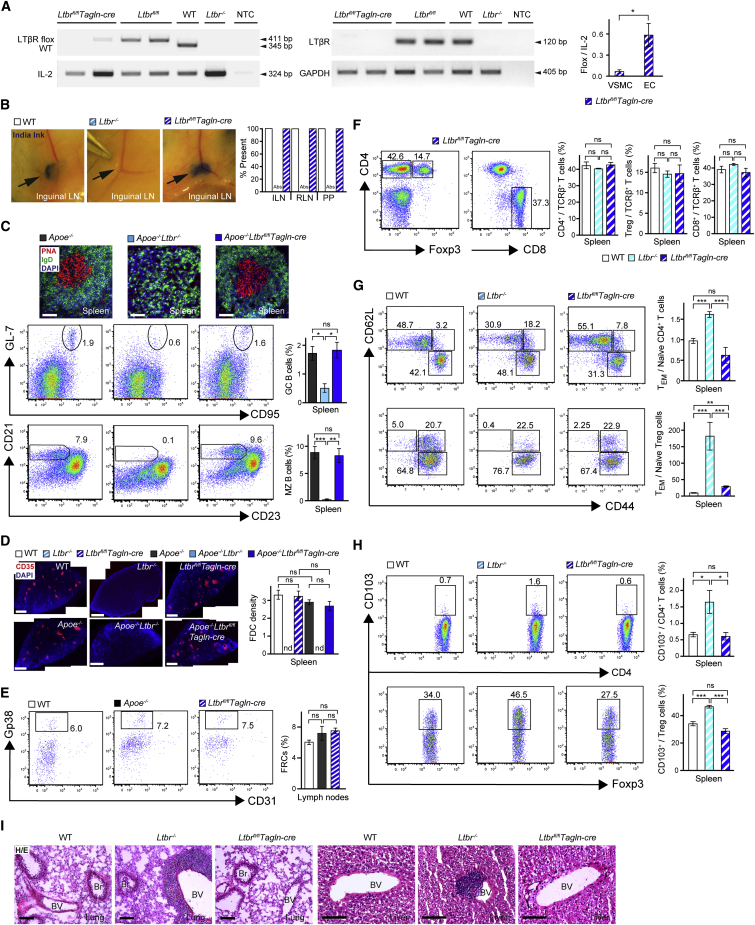
The Immune System of VSMC-LTβR Deficient Mice(A) Ltbr deletion in VSMCs. Validation of genomic Ltbr deletion in freshly isolated aortic VSMCs by PCR (left) and of Ltbr mRNA (middle); qRT-PCR show reduction of floxed Ltbr sequences in cultured aortic VSMCs compared to aortic endothelial cells (ECs) (n = 3 experiments) of Ltbrfl/flTagln-cre mice (right); NTC, no template control.(B) SLO neogenesis. Inguinal LNs (ILNs) were visualized by India ink injection into footpads of 8- to 10-week-old mice (n = 8) (left panels, arrow); all other LNs (data not shown) show similar results. SLOs in WT, Ltbr−/−, and Ltbrfl/flTagln-cre mice (n = 8) (right); RLN, renal LN; PP, Peyer’s patches; Abs, absent.(C) GC and MZ B cells in spleen. PNA+ GC B cells and IgD+ follicular MZ B cells in spleen (upper panel) (n = 8–12 sections in 5–7 mice per genotype). Flow cytometry show GC (middle panel) and MZ B cells (lower panel) in B220+ B cells from 78- to 80-week-old mice.(D) FDCs in spleen. Representative lower magnification montages of CD35+ FDCs and quantification of FDCs in spleen (n = 8–12 sections in 5–7 mice per genotype).(E) FRCs in LNs. Flow cytometry of Gp38+CD31− FRCs of CD45−Ter119− cells in LNs of 78- to 90-week-old mice (left panel).(F) T cell subsets in spleen. Flow cytometry of CD4+Foxp3− T cells, CD4+Foxp3+ Treg cells, and CD8+ T cells of TCRβ+ cells of 78- to 90-week-old Ltbrfl/flTagln-cre mice.(G) TEM and naive T cells in spleen. Flow cytometry of CD62L+CD44− naive, CD62L−CD44+ TEM, and CD62L+CD44+ TCM cells of CD4+ T cells of 78- to 90-week-old mice; TEM per naive T cell ratios of CD4+ T cells (upper panel) or CD4+ Treg cells (lower panel).(H) CD103+ cells in spleen. Flow cytometry plots show CD103+ cells from CD4+ (upper panel) or Treg (lower panel) cell gate of 78- to 90-week-old mice; bar graphs show the percentage comparison of CD103+ cells among CD4+ T or Treg cells at right.(I) Perivascular infiltrates in peripheral tissues. Hematoxylin and eosin (H/E) staining show leukocyte infiltrates around blood vessels (BVs) in lungs and liver. n = 3 mice per genotype. Br, bronchiole. Scale bar represents 50 μm (C and I); 500 μm (D). Flow cytometry data are representative of three experiments with pooled one to two mice per genotype per experiment (C and E–H). Data represent means ± SEM; p values were determined by unpaired Student’s t test or by multiple testing (Bonferroni) using the GEE model as described in the Experimental Procedures. ∗p < 0.05; ∗∗p < 0.01; ∗∗∗p < 0.001; ns, not significant (see also Figure S6).